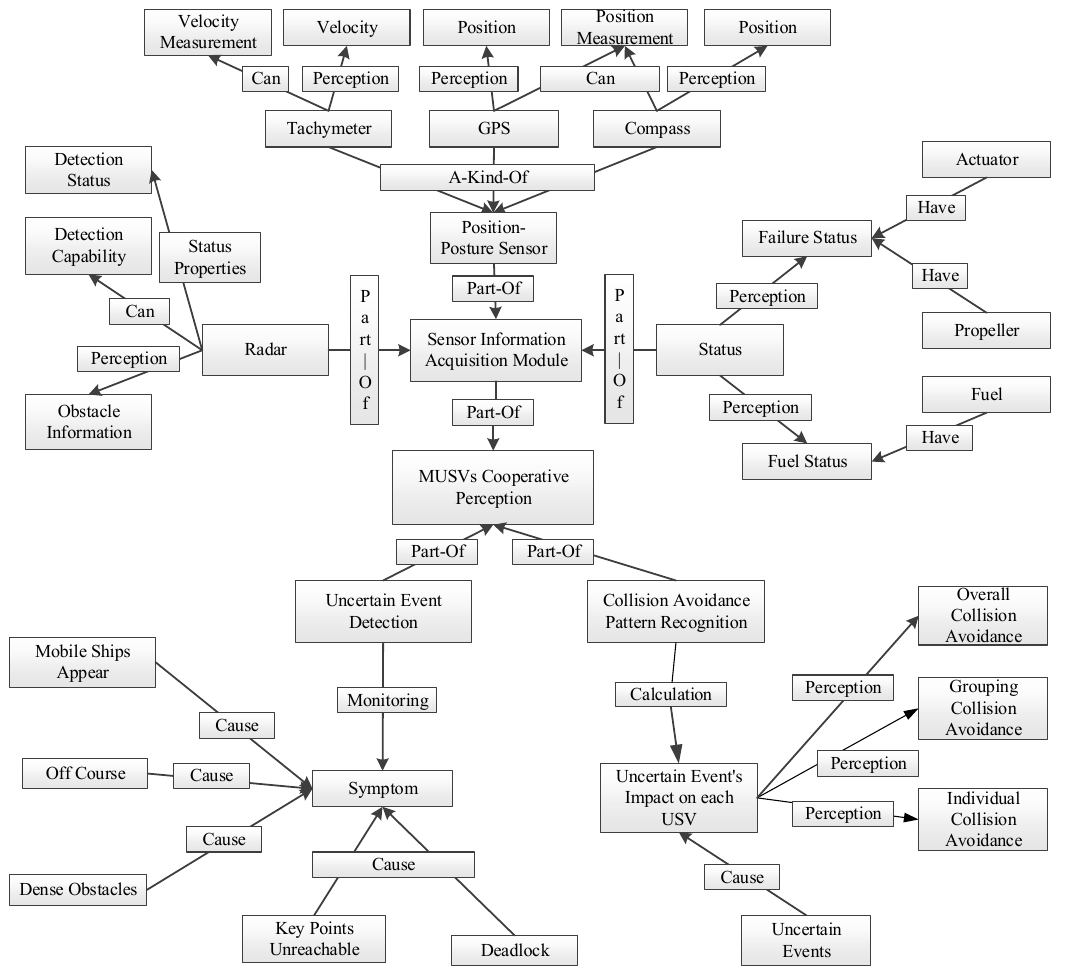
Figure 2. Semantic knowledge framework for cooperative perception application ontology.